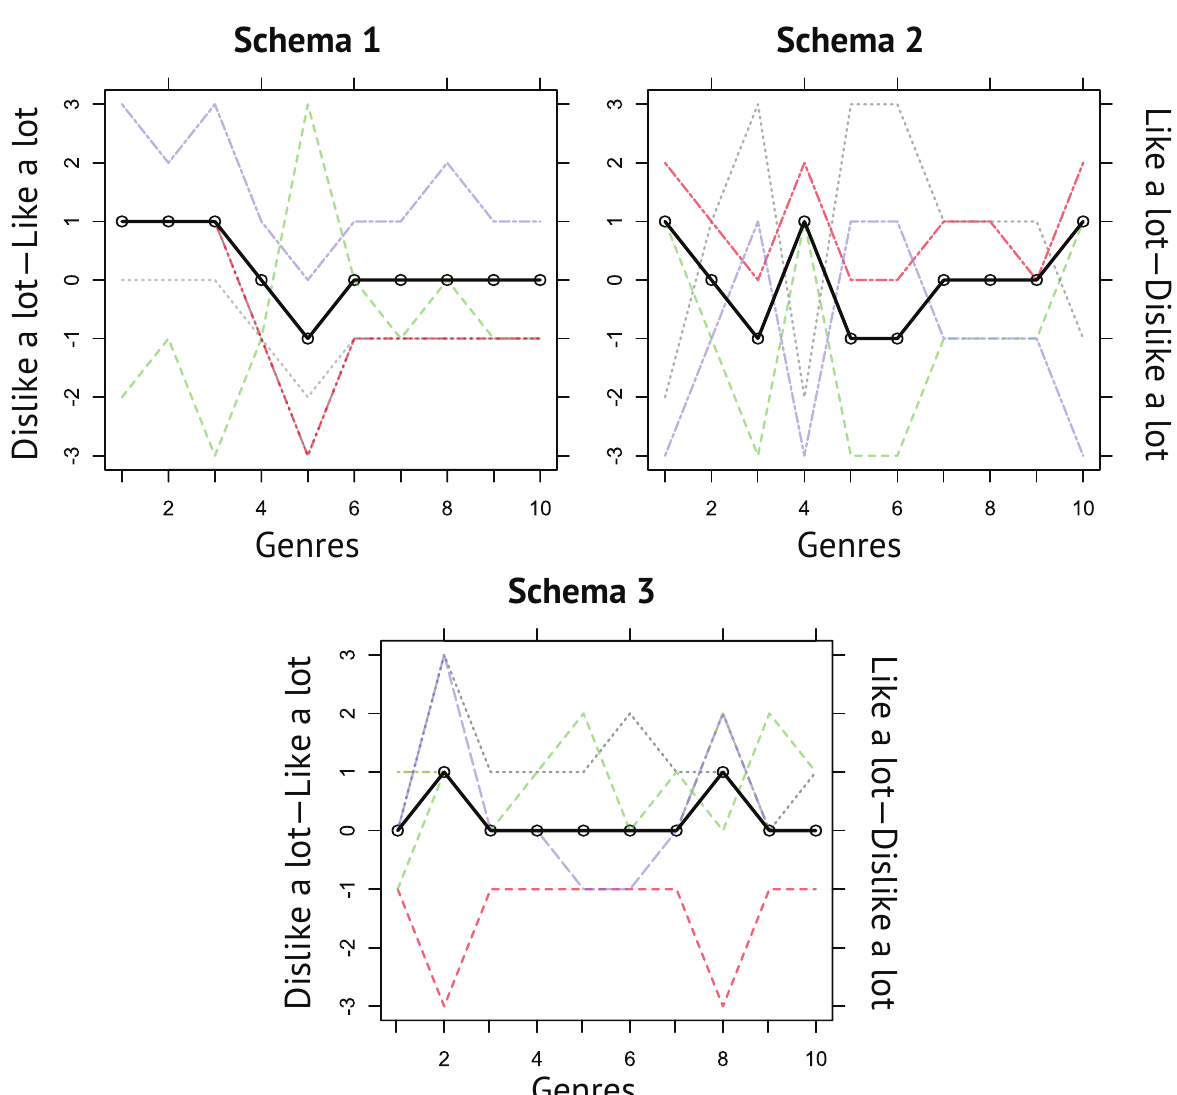
Figure 4: Three simulated schemas (solid black) for one simulation run with a small sample of responses derived from each schema depicted behind each one in the same plot (dashed). In this run, the pattern variance was 0.51, and the maximum noise variance for individual responses was 1.05. This moderately high ratio of noise-to-schema variance creates a relatively difficult classification